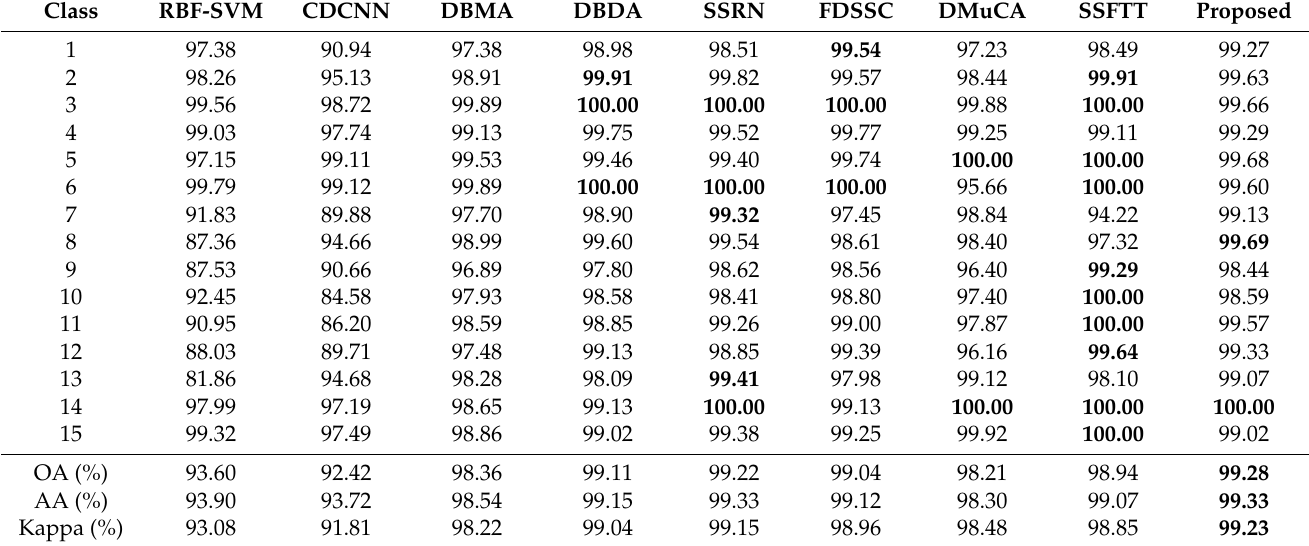
Table 7. Classification results of the Houston dataset using 10% training